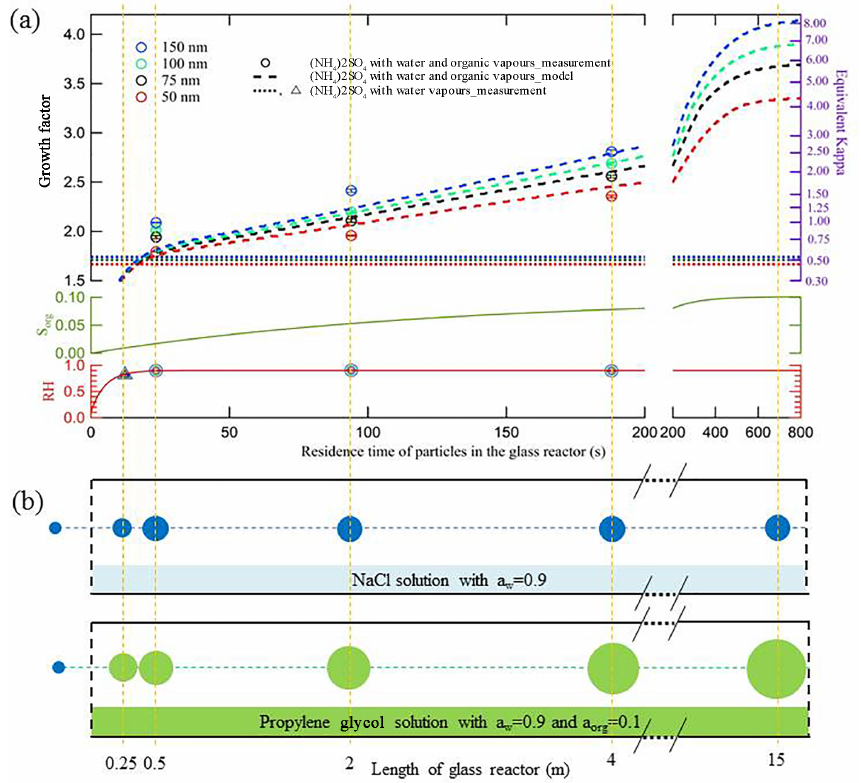
Figure 4. Growth of (NH 4 ) 2 SO 4 particles exposed to water and propylene glycol, PG, vapours. (a) Measured (circle) and simulated (dash line) GFs with the residence time, the equivalent hygroscopicity (the κ that an involatile particle would need in order to show the growth factor (GF) in the absence of co-condensing vapours) corresponding to the GF axis is presented on the right-hand axis of the top panel; the simulated RH and S org profiles are presented as solid red and green lines, respectively. (b) Schematic illustration of 100nm (NH 4 ) 2 SO 4 particles growth in the glass reactor, particle diameters to